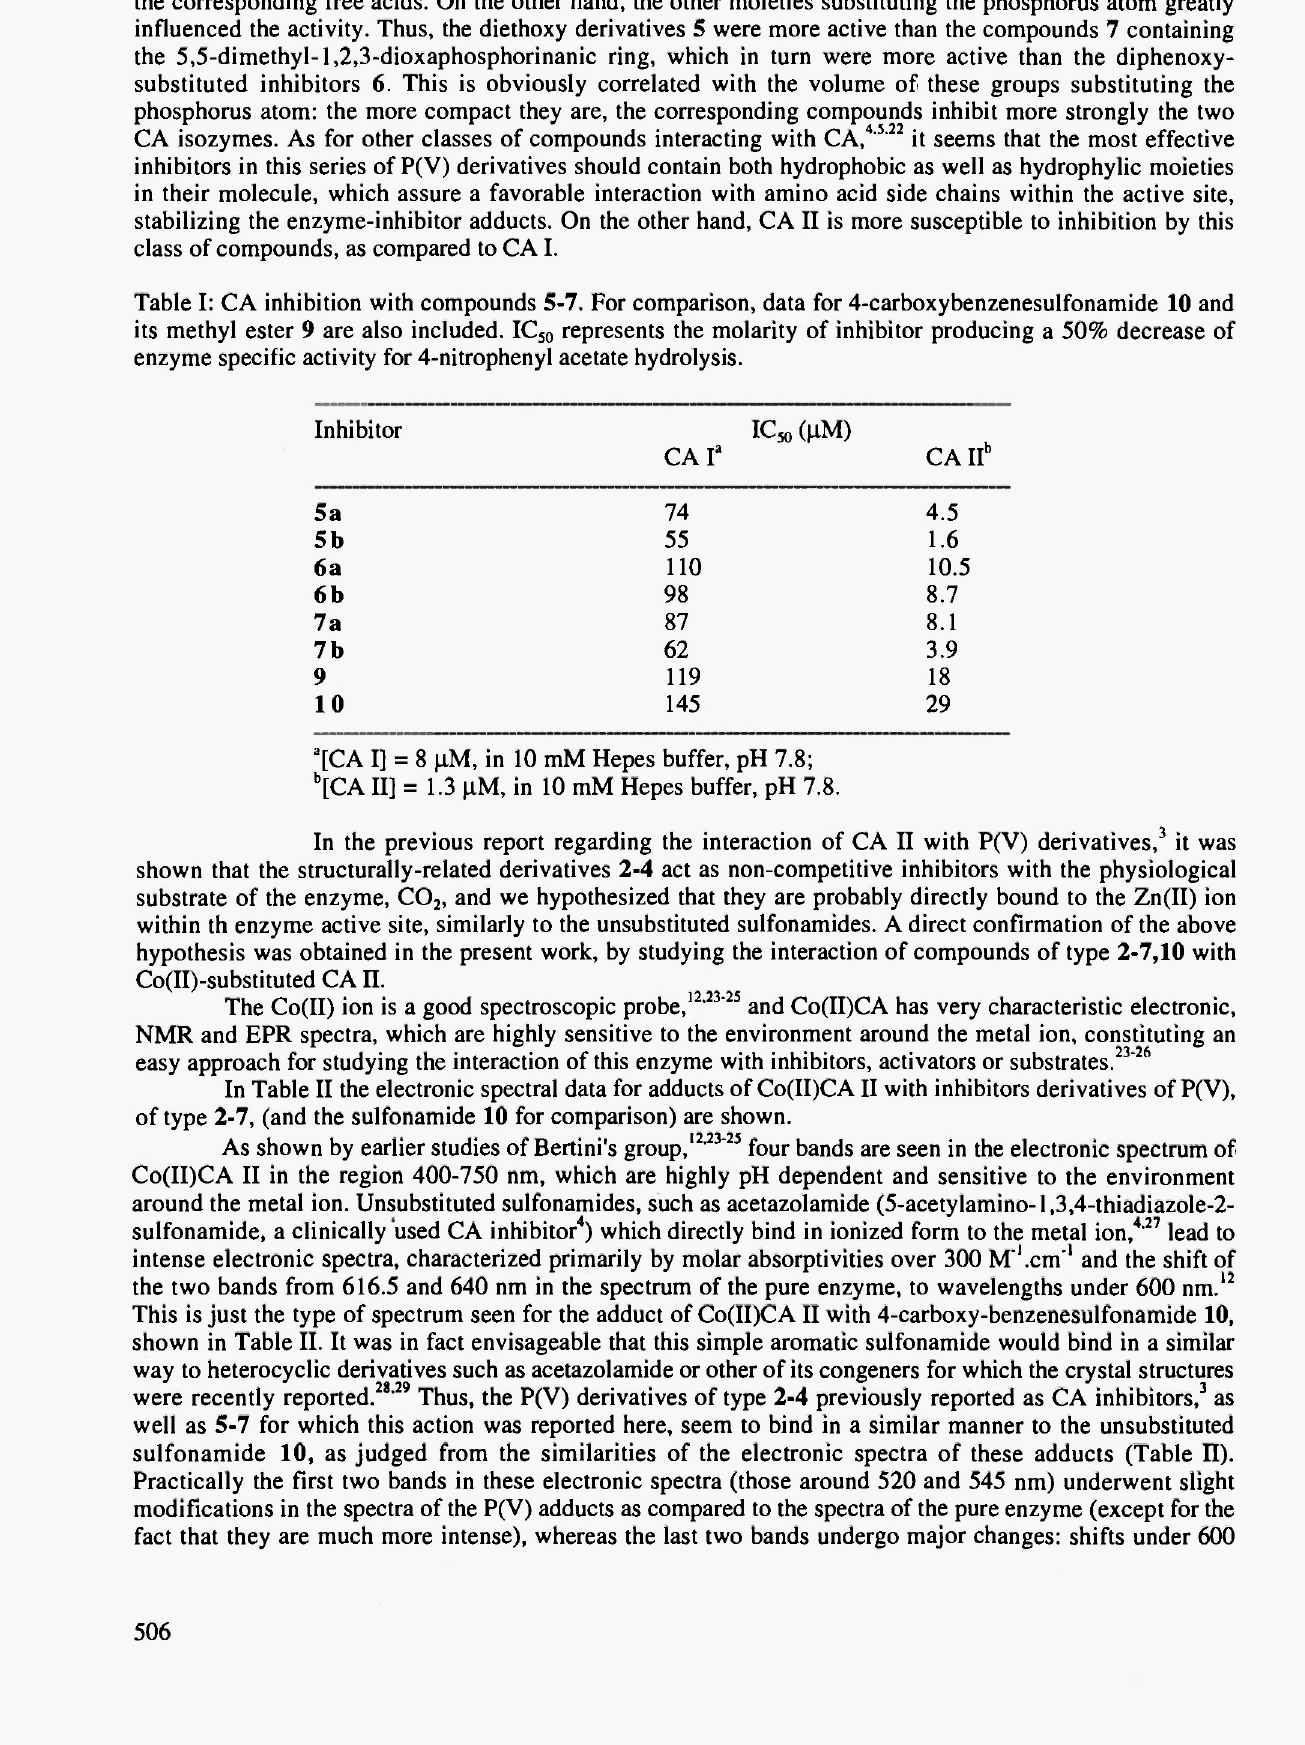
Table I: CA inhibition with compounds 5-7. For comparison, data for 4-carboxybenzenesulfonamide 10 and its methyl ester 9 are also included. IC 50 represents the molarity of inhibitor producing a 50% decrease of enzyme specific activity for 4-nitrophenyl acetate